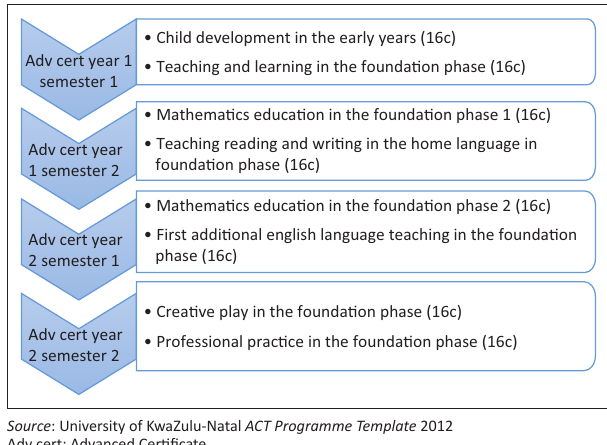
FIGURE 1: Advanced Certificate in Teaching programme: Module flow chat with allocated credit